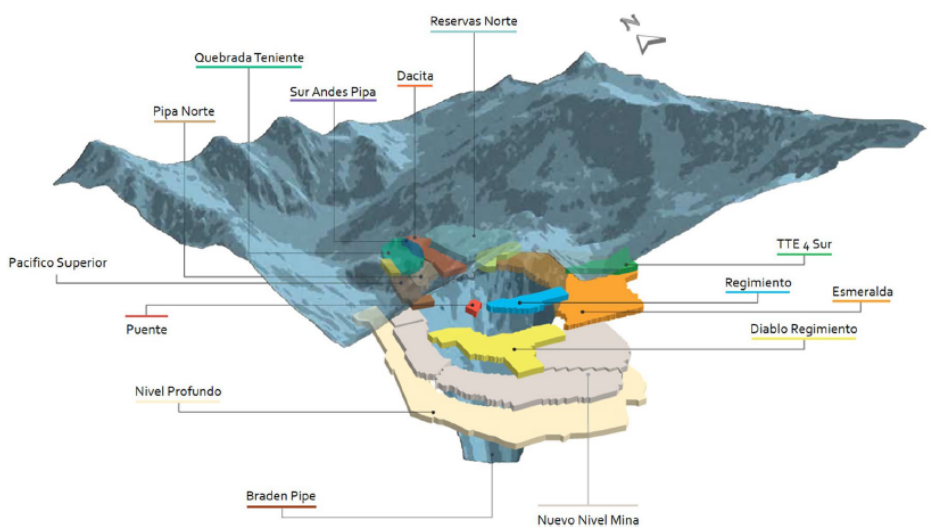
Figure 6. Location of different exploitation levels around Pipa Braden [50].